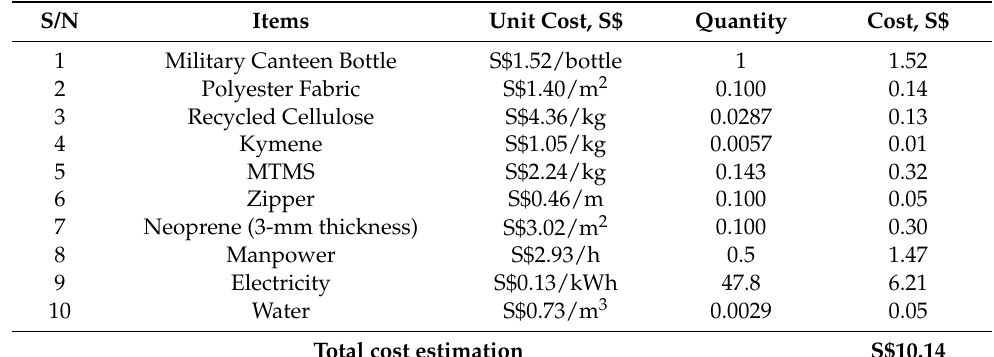
Table A2. Estimated cost of manufacturing the insulated jacket.